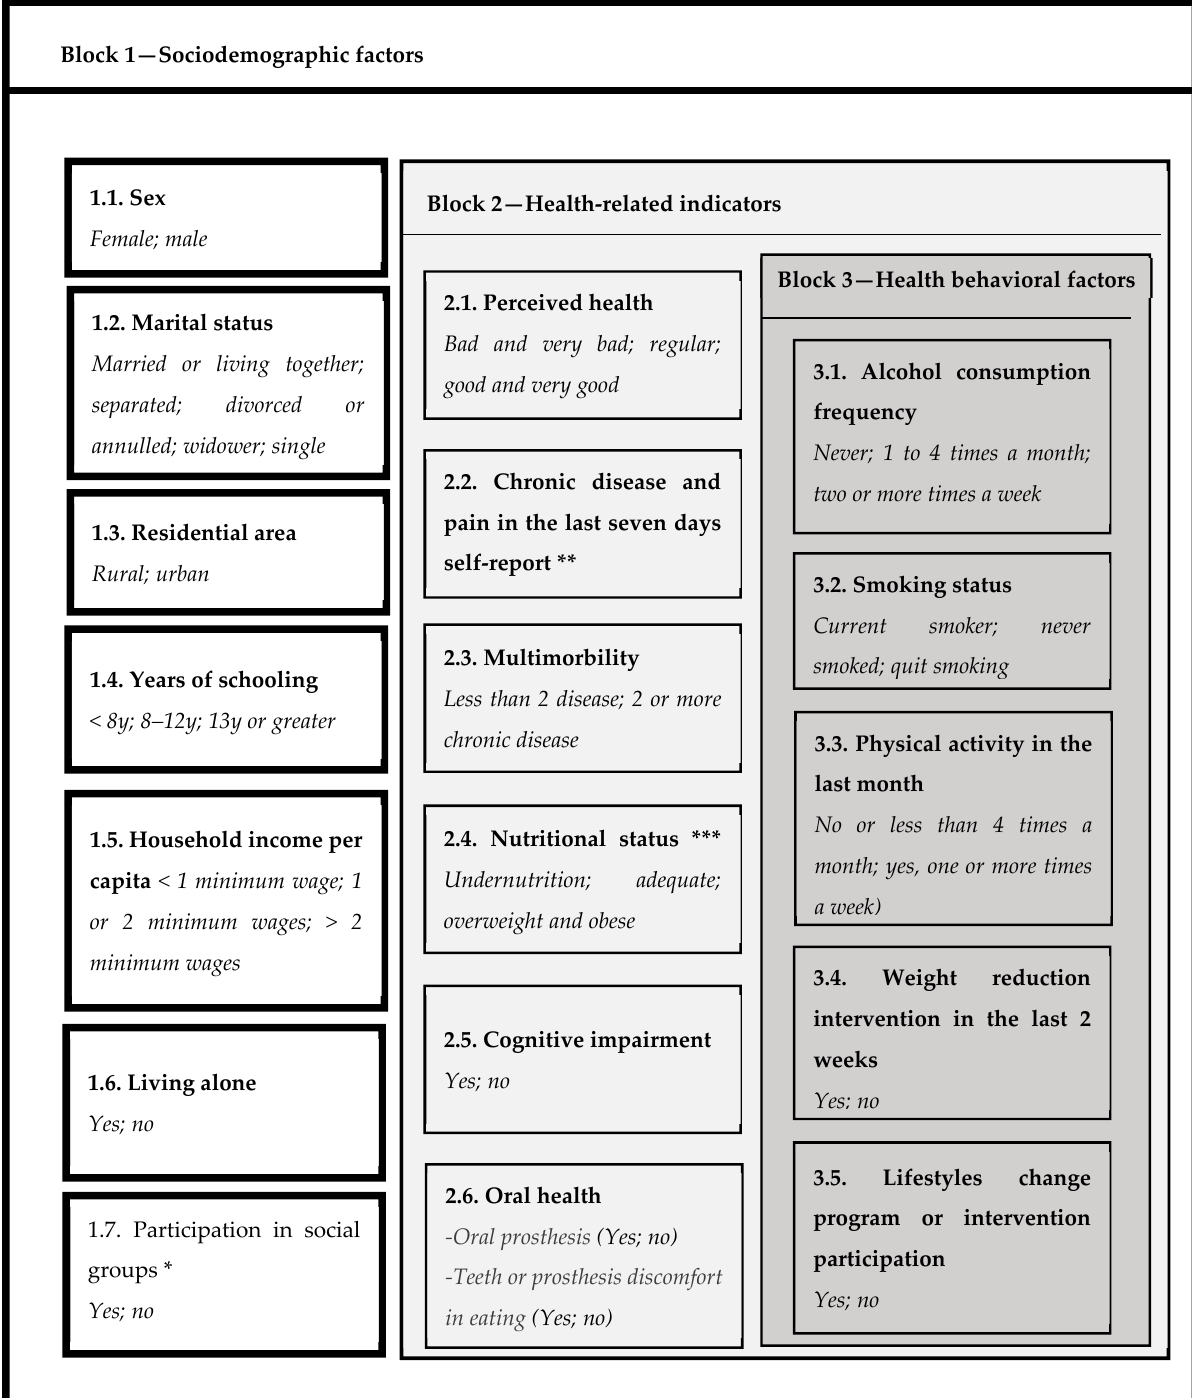
Figure 1. Hierarchical blocks and categories of independent variables. * Social groups: sports, volunteer, or hobby groups, senior citizen clubs, neighborhood or resident associations, study or cultural groups, religious organizations, or church participation. ** The self-report of chronic disease includes cardiovascular (hypertension, heart attack, stroke, and high cholesterol); eye disorders, such as cataracts and glaucoma; and osteoarticular diseases (arthritis, osteoarthritis, and osteoporosis). The pain self-report includes muscle, bone, or joint pain. *** The nutritional status categories were defined as undernutrition (BMI < 23 kg/m 2 ), adequate (BMI 23.0–27.9 kg/m 2 ), overweight (BMI 28.0–29.9 kg/m 2 ), and obese (BMI ≥ 30 kg/m 2 ).